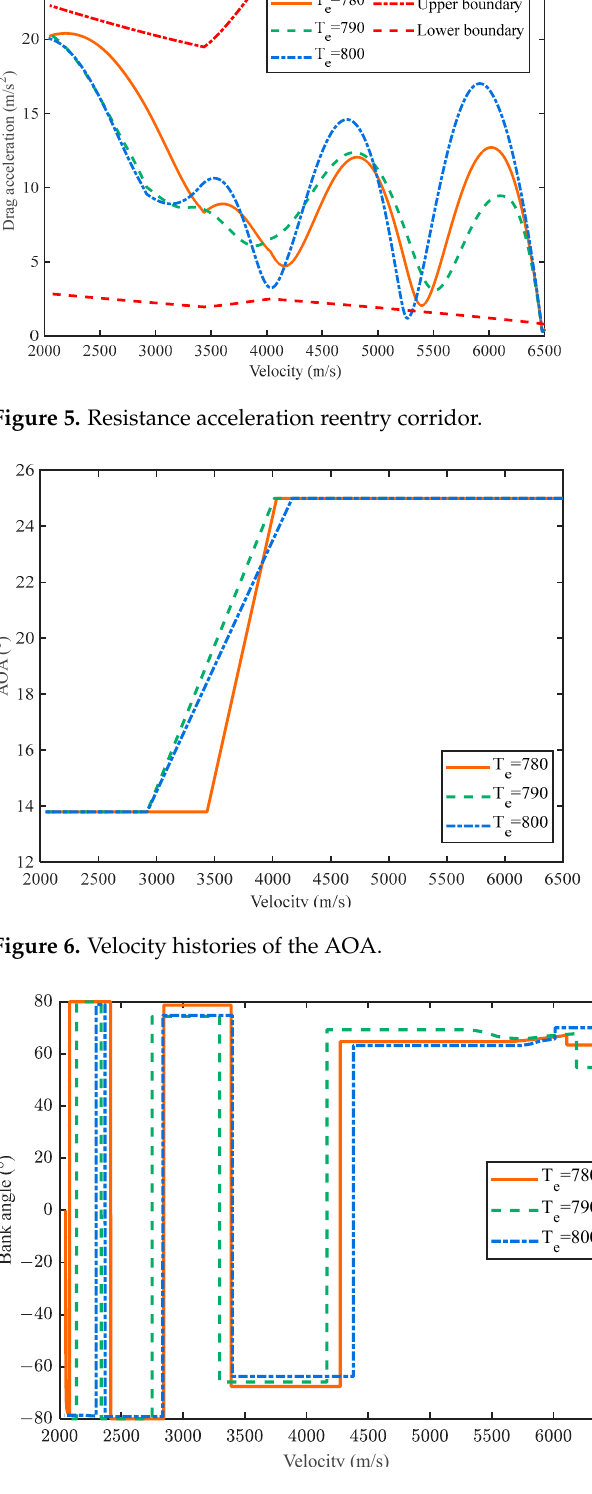
Figure 7. Velocity histories of the bank angle.